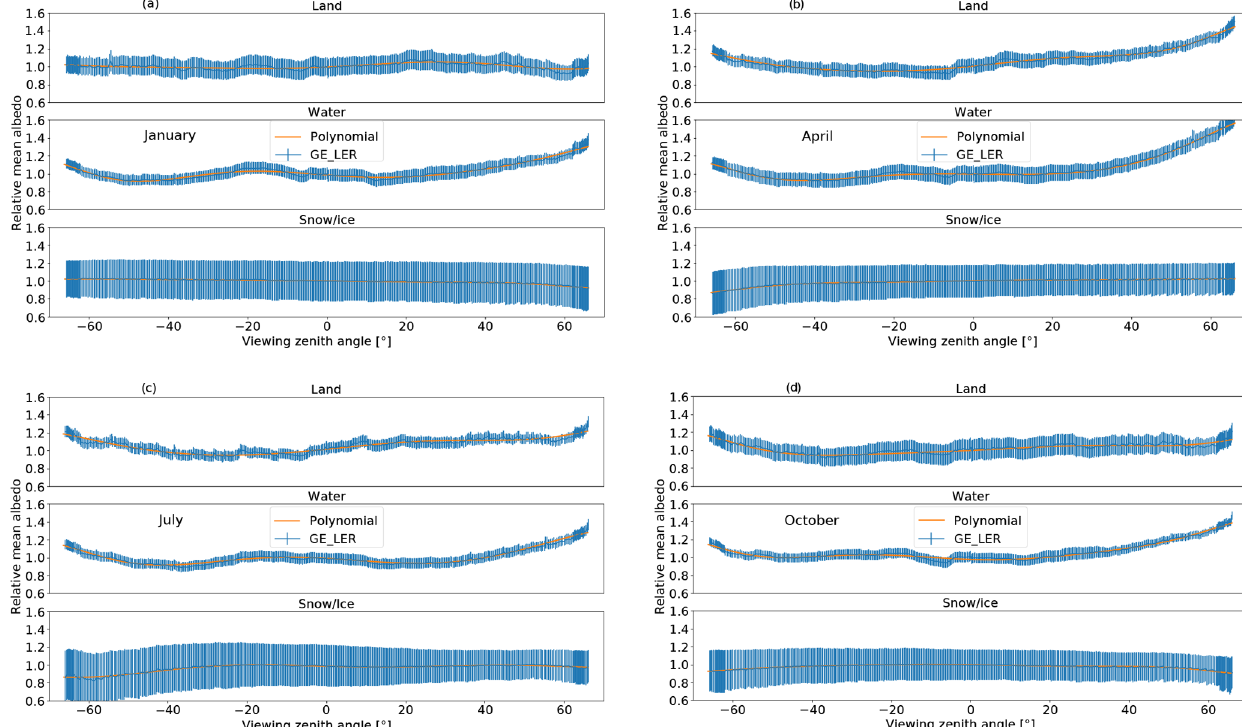
Figure 8. BRDF dependencies ρ(θ) as a function of the viewing zenith angle for land, water, and snow/ice conditions, as calculated with normalized TROPOMI/S5P data from (a) January, (b) April, (c) July, and (d) October 2018. The negative viewing zenith angles correspond to the first 225 detector